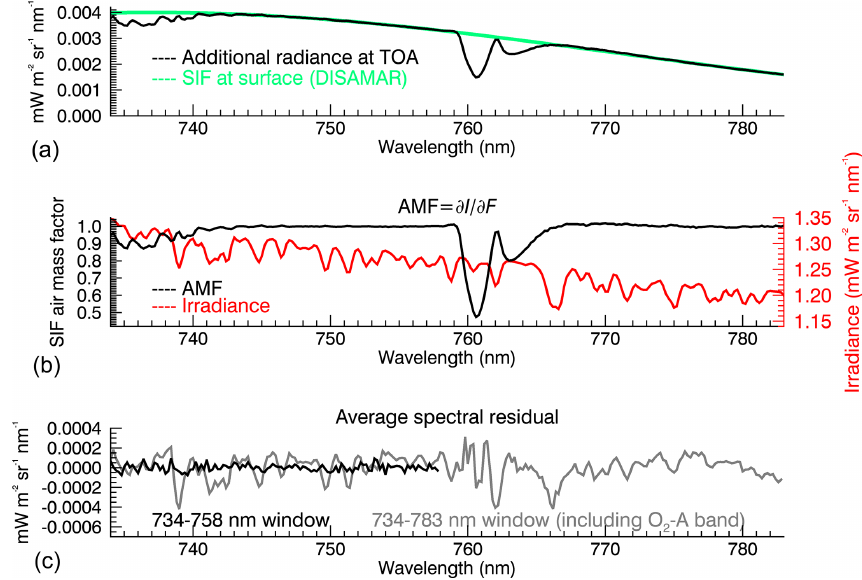
Figure 3. (a) Difference between ensemble-average simulations of top-of-atmosphere radiances with and without a SIF signal present at the surface (black line). The DISAMAR ensemble consists of 140 simulations with an average surface pressure of 977hPa, surface albedo of 0.46 (at 750nm), and geometrical AMF (defined as ( cos θ) − 1 ) of 1.21. The fluorescence at the surface in green has a Gaussian shape with a peak at 737nm of 4mWm − 2 nm − 1 sr − 1 and a width of 33.9nm. (b) SIF AMF as a function of wavelength, and solar irradiance (red) based on the high-resolution spectrum from Chance and Kurucz (2010) convolved with the GOME-2A slit function. (c) Average spectral fitting residuals for end-to-end retrievals with the narrow (734–758nm) and wide (734–783nm)